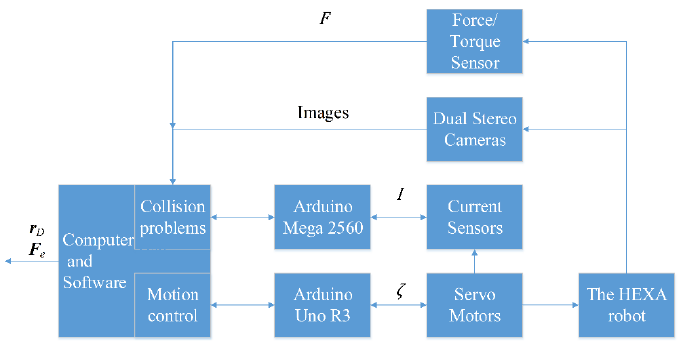
Figure 6. The block diagram of the Hexa robot system.